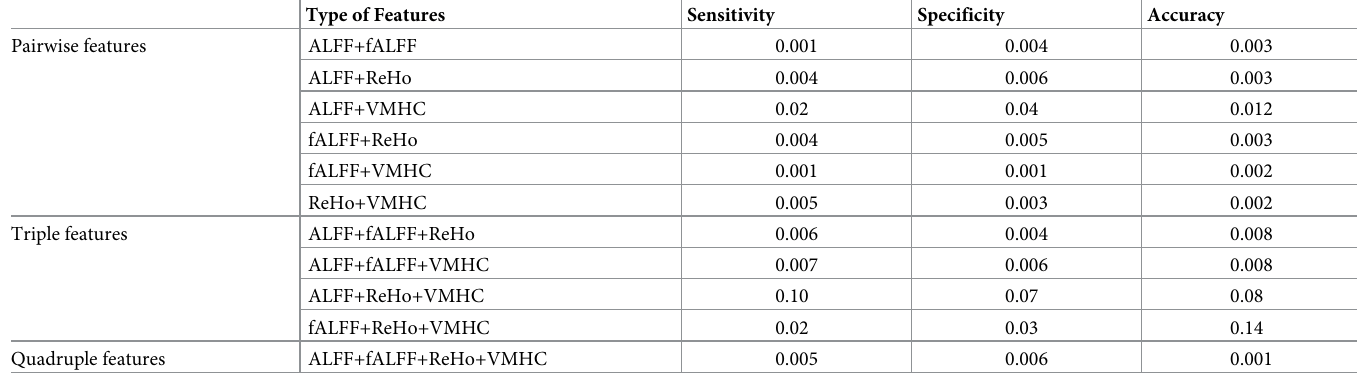
Table 6. P-values for test of significance of the outcomes of the classifiers based on feature-level fusion of different pairwise, triple, and quadruple combinations of single feature types. Statistical comparison is made with respect to the ReHo-based